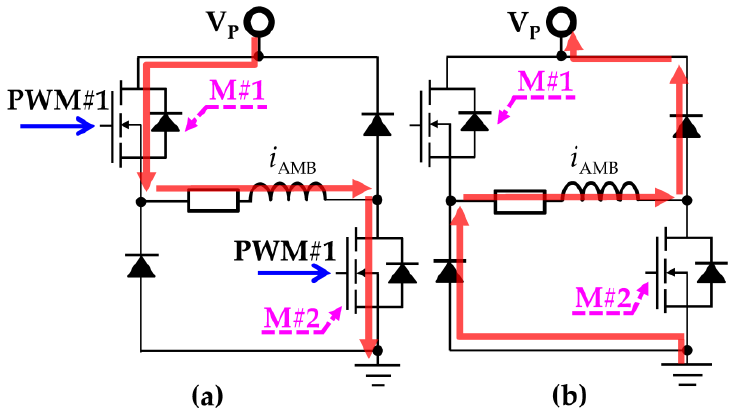
Figure 2. Operation states of DC 2 (dual cooperative drive circuit) under DDM (digital driving mode): ( a ) charge state; ( b ) discharge state.